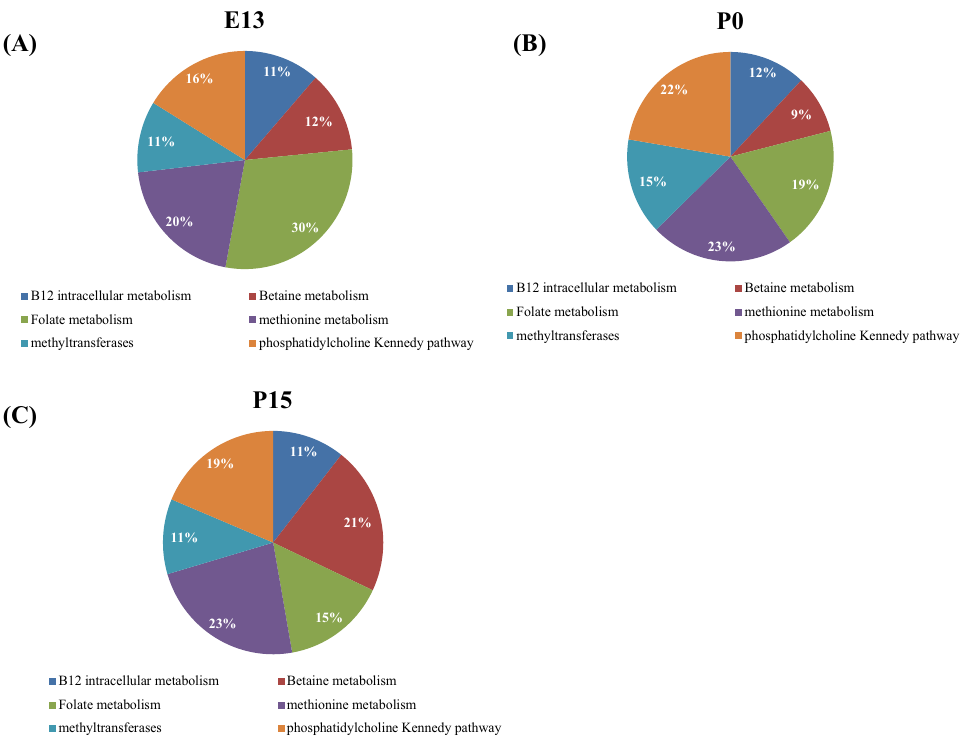
Figure 7. Percentages of brain mRNA expression of genes according to their metabolic pathway at a prenatal stage at embryonic day 13 ( A ), at birth ( B ) and at a postnatal stage, 15 days after birth ( C